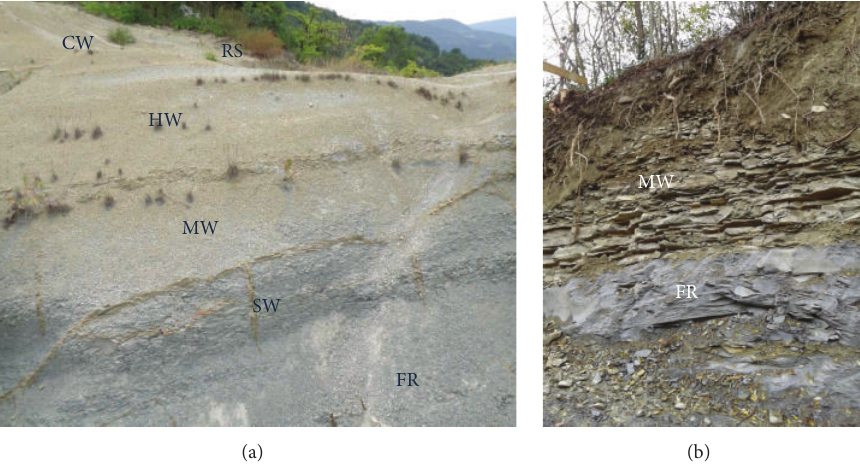
Figure 5: Locations of samples that were collected for laboratory testing from flysch outcrops near (a) Cunj Village and (b) Sovinjak Village.